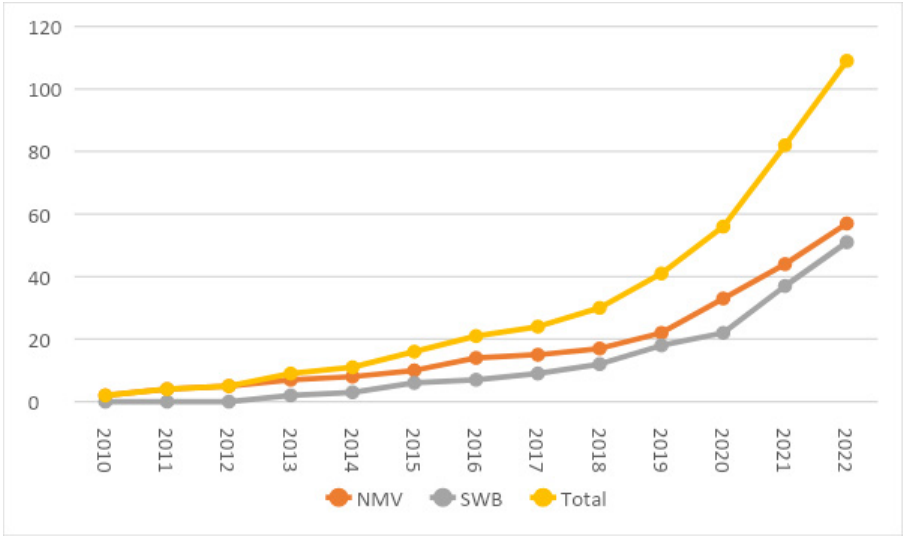
Figure 3. Cumulative number of articles by year (2010–2022).